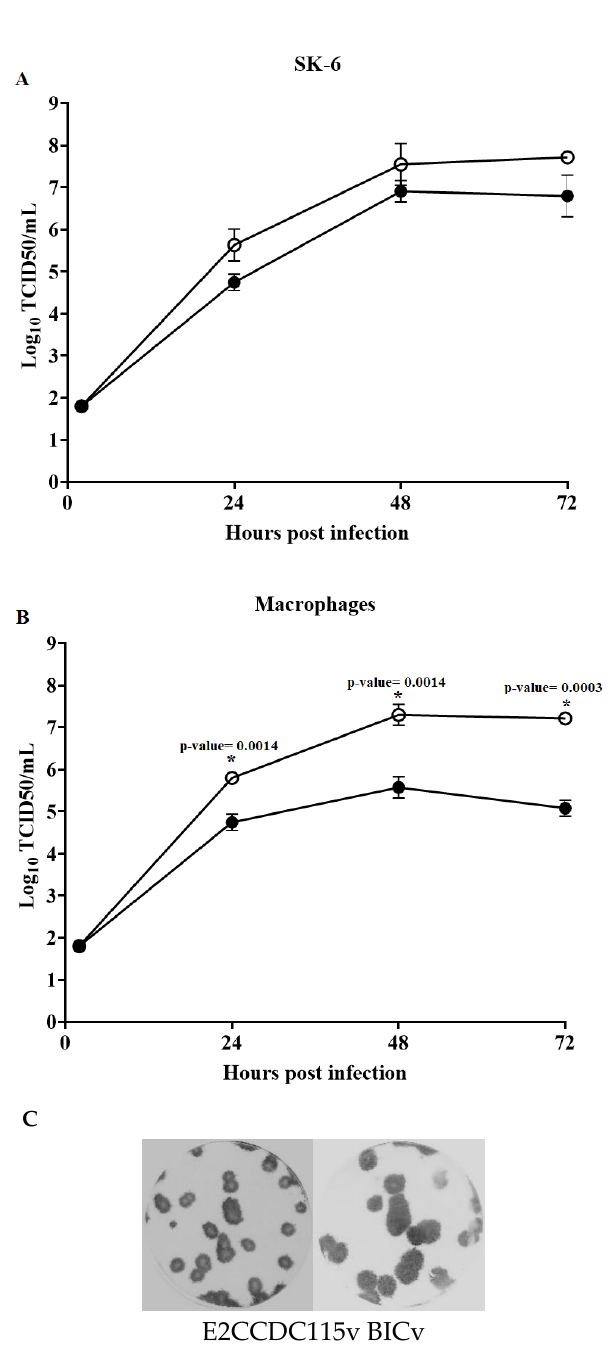
Figure 3. In vitro growth characteristics of CSFV E2ΔCCDC115v . Multistep growth curve of E2ΔCCDC115v and BICv error bars represent the average and standard deviation for the titers of hree independent experiments on ( A ) SK6 cells and ( B ) swine macrophage cell cultures. Cell cultures were infected (MOI of 0.01) with CSFV BICv (empty symbols) or E2ΔCCDC115v (filled symbols). At indicated times post-infection, samples were collected and titrated for virus yield. Data are means and the bars represent the standard deviation of three independent experiments. Significant differences (*) in viral yields in SK-6 cells and macrophages between both viruses at specific times points were determined using the Holm–Sidak method ( α = 0.05), without assuming a consistent standard deviation. All calculations were conducted on the software GraphPad Prism version 8. ( C ) Plaque formation of CSFV E2 ∆ CCDC115v and BICv on SK6 cell cultures. Cell cultures were infected with either virus, overlaid with 0.5% agarose, incubated at 37 ◦ C for 4 days, fixed with 50% ( v / v ) ethanol / acetone, and stained by immunohistochemistry as described in Materials and